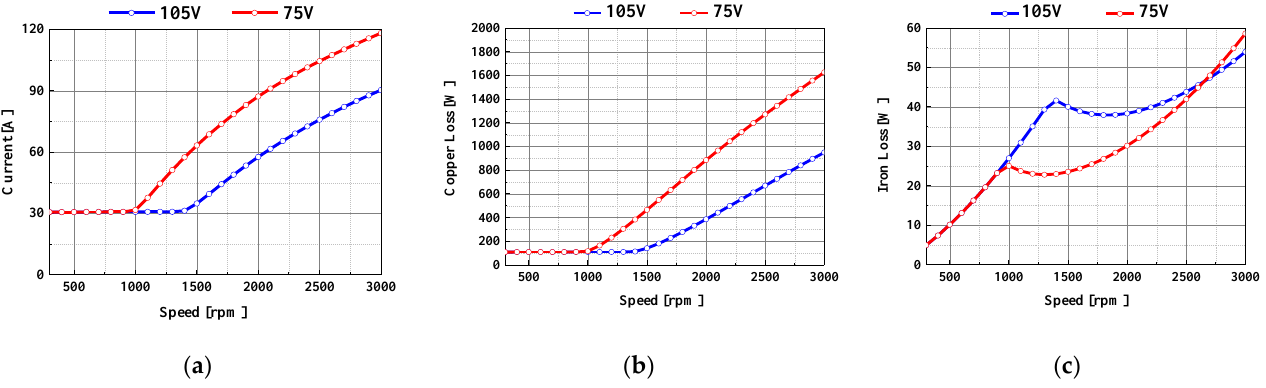
Figure 8. Current and loss according to V dclink : ( a ) current, ( b ) copper loss, and ( c ) iron loss.